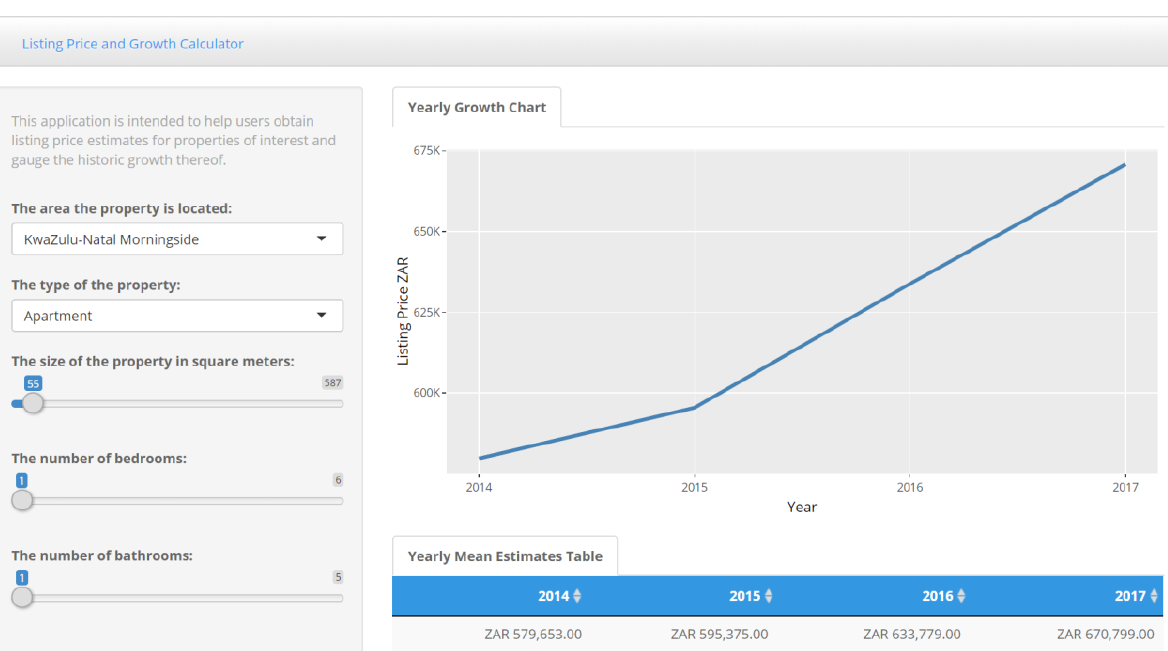
Figure 5: Listing Price and Growth Calculator (example one) This example shows the mean price estimates for a house in Gauteng Bryanston that that is 400m 2 in size with 4 bedrooms and 4 bathrooms. The mean estimates are plotted in a chart over time, and tabulated.